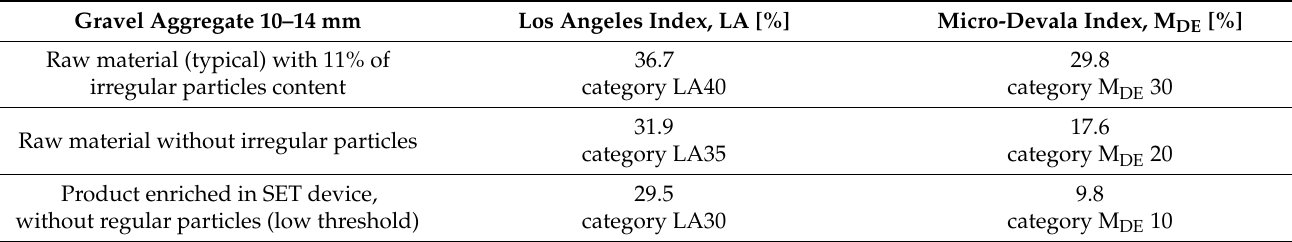
Table 9. Results of Los Angeles and micro-Deval indices for a gravel aggregate in particle size fraction 10–14 mm at different stages of enrichment.